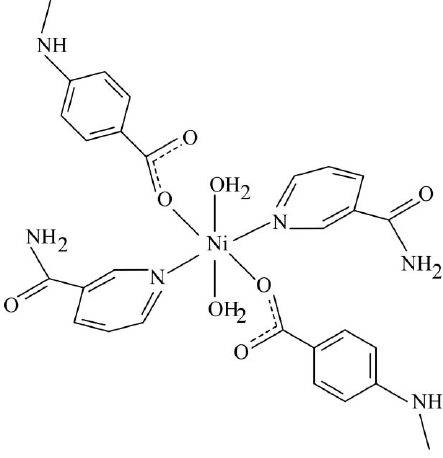
Experimental Crystal data